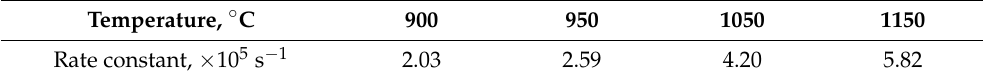
Table 1. Rate constants for the reduction of barite compacted sample (zone A) with brown coal. Temperature, ◦ C